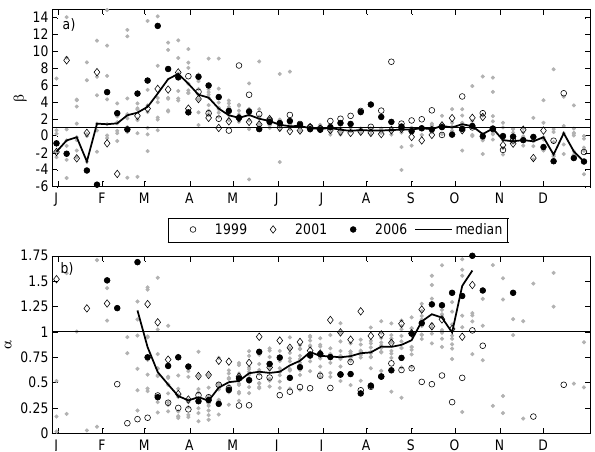
Fig. 6. Seasonal and inter-annual variability of (a) Bowen ratio ( β ) and (b) Priestley-Taylor α = LE/LE eq . The points represent weekly averages and the thick solid line the median over 1997–2008. The β is weighted by global radiation and hence represents the daytime conditions while α is calculated from weekly sums. In November– February the median is not shown because of large variability of β and α